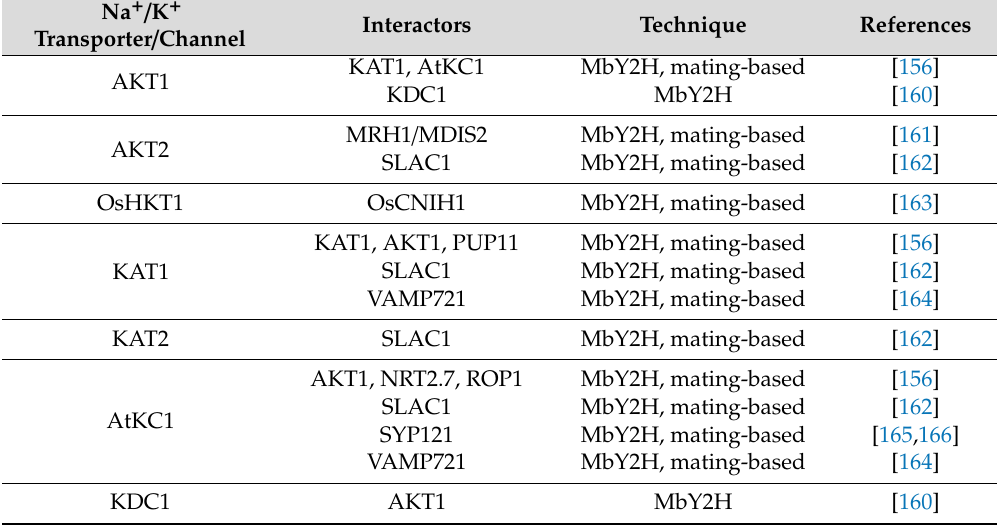
Table 3. Interactors of K + / Na + transporters / channels detected using protein–protein interaction techniques in